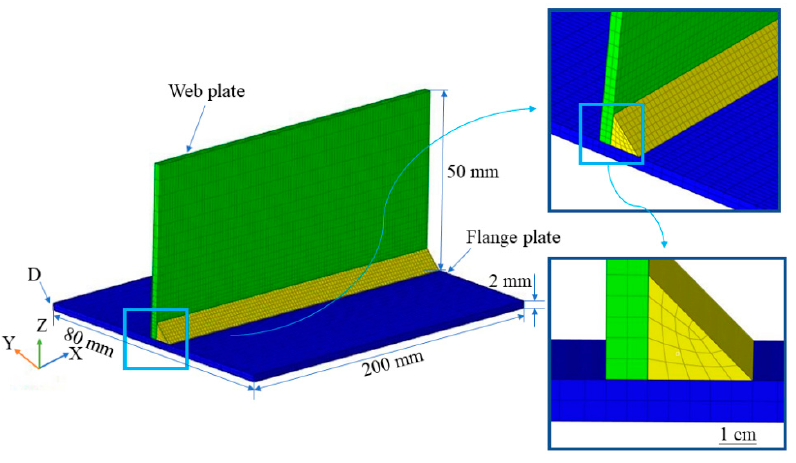
Figure 1. T-joint FE model.